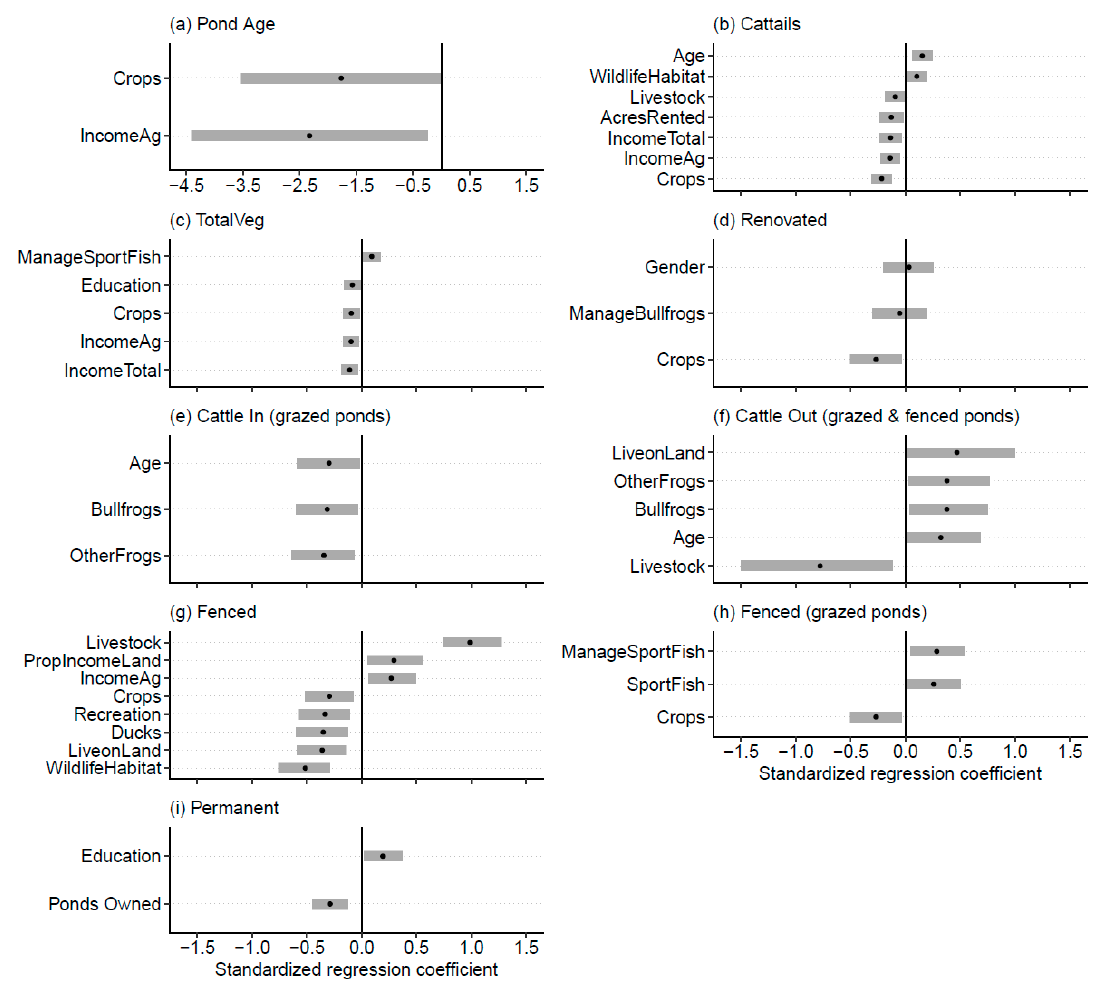
Figure 6. Estimated effect size (standardized regression coefficient from mixed-effects regression; black dot) and 85% confidence intervals (gray bars) for eight response variables related to management and habitat quality of ponds in Southern Iowa. For each response variable, only predictor variables with greater support than the null model are shown (based on Akaike’s Information Criterion [AIC]; see Table 2). Note, for Pond Age, tick marks are spaced at one-unit intervals.